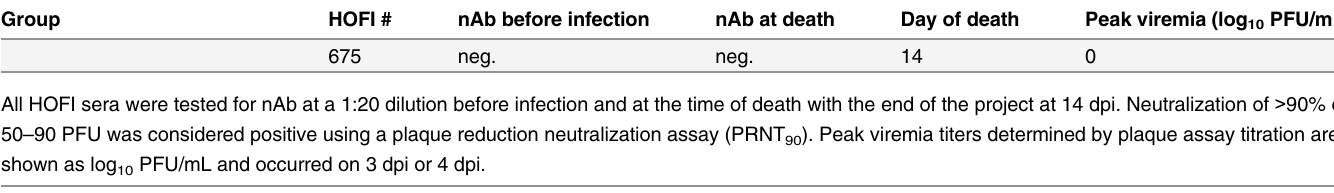
PLOS ONE | DOI:10.1371/journal.pone.0125668 May 12,